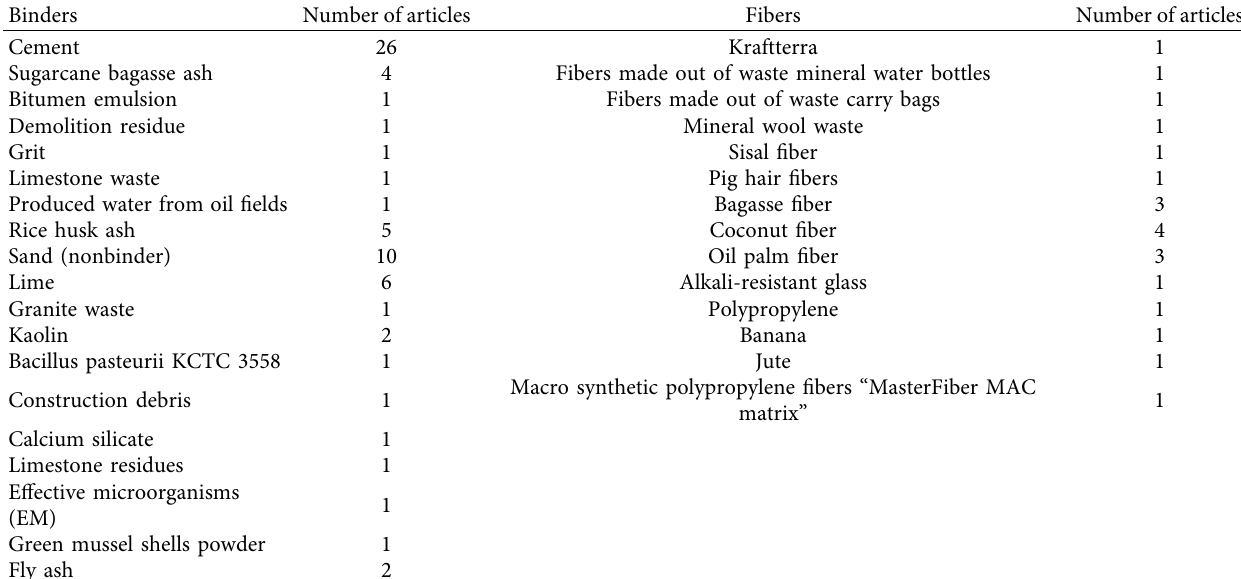
Table 5: Frequency of binders and fibers present in soil block that has been reported in the articles ( n � 36) reviewed.